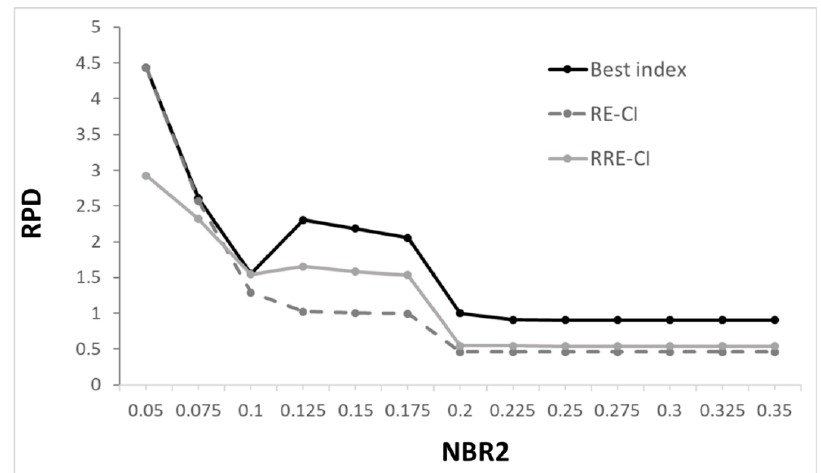
Figure 9. Ratio of performance to deviation (RPD) of validation using different Sentinel-2 indices and Normalized Burn Ratio 2 (NBR2) index thresholds.